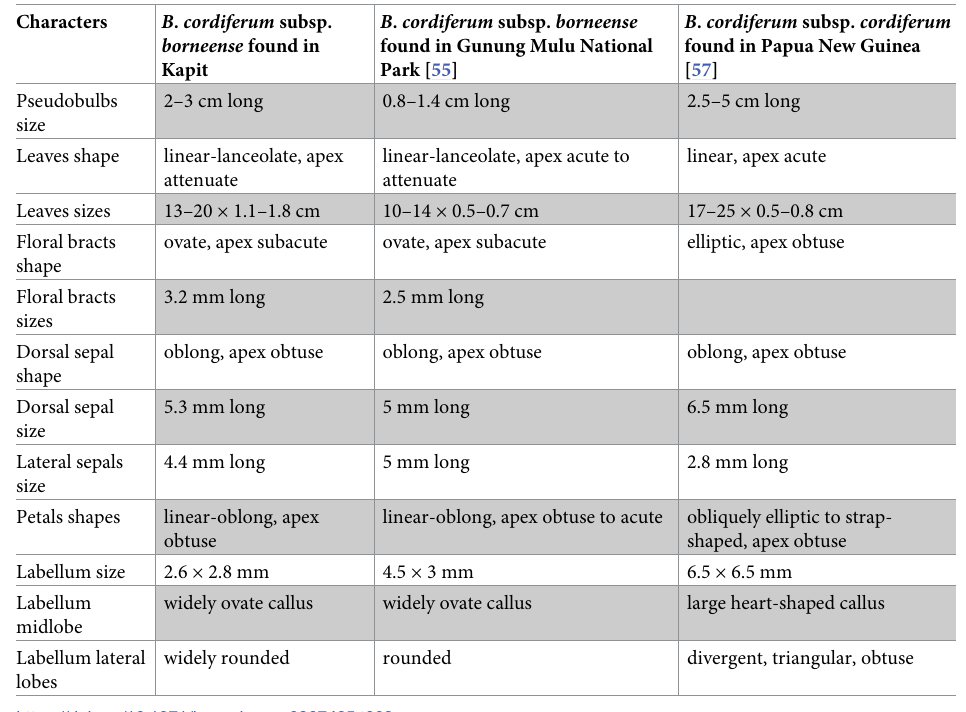
Table 2. Comparison of morphological characters of B . cordiferum subsp. borneense found in Kapit, B . cordiferum subsp. borneense found in Gunung Mulu National Park, and B . cordiferum subsp. cordiferum found in Papua New